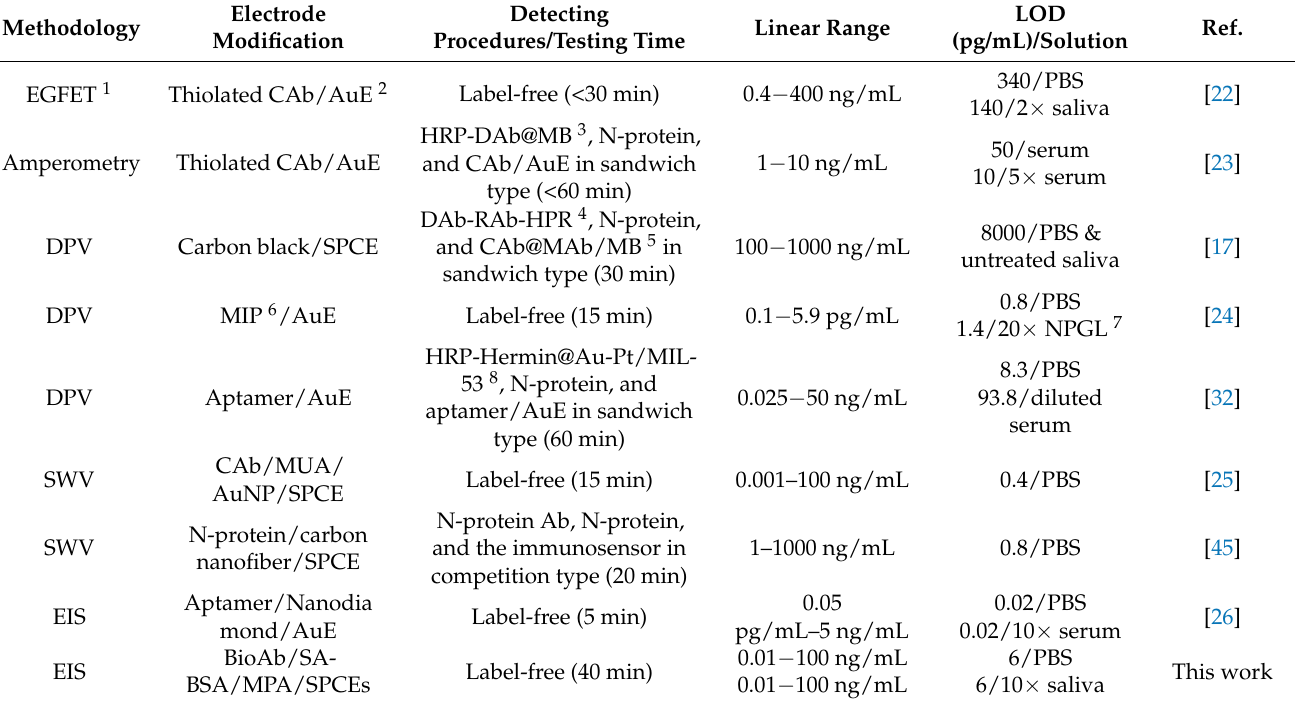
Table 2. Sensing properties and detecting strategies of SARS-CoV-2 N-protein electrochemical immunosensors between this study and previous